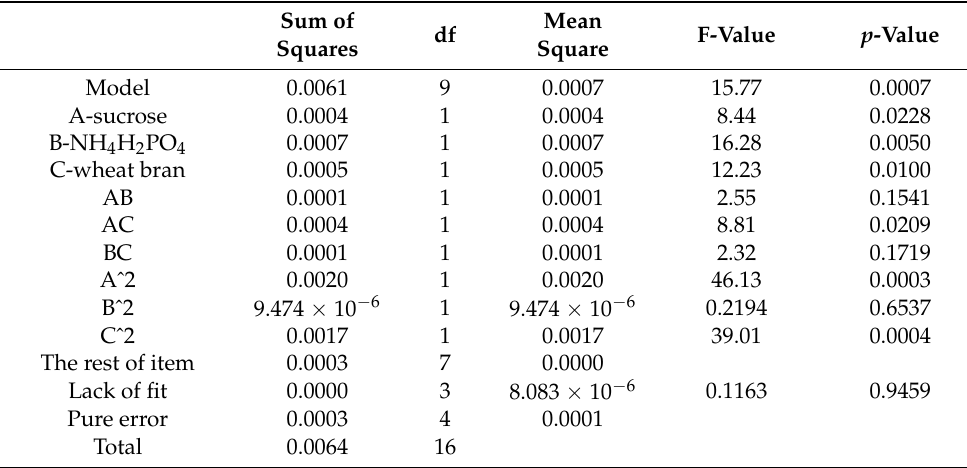
Table 7. Statistical analysis of the model from the